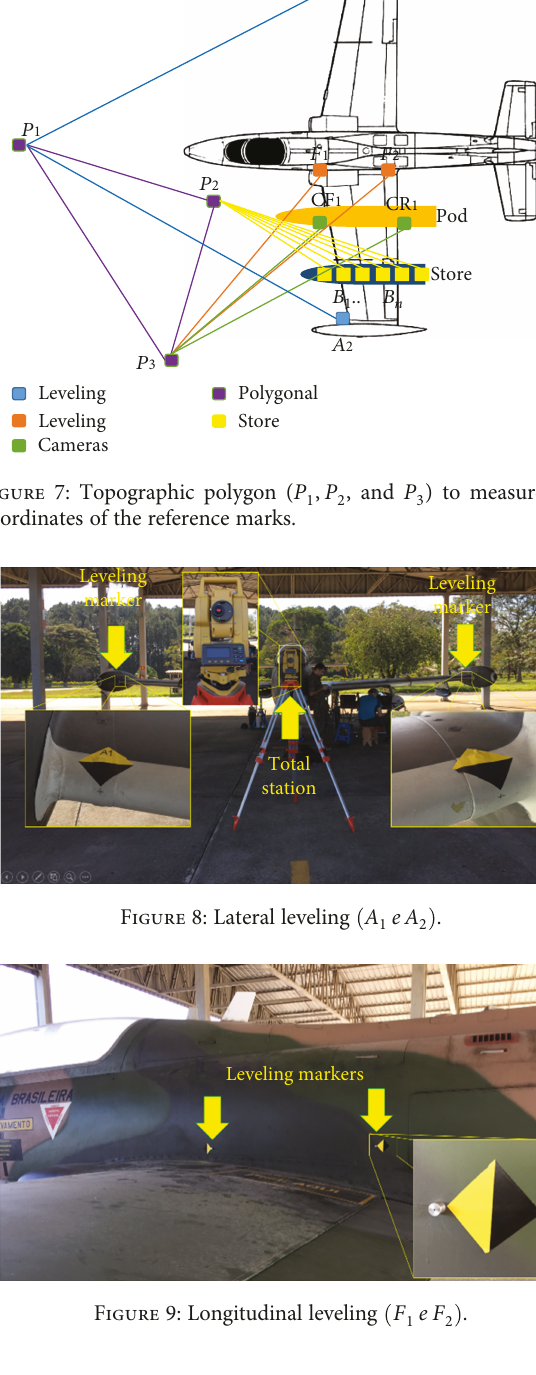
Figure 9: Longitudinal leveling F